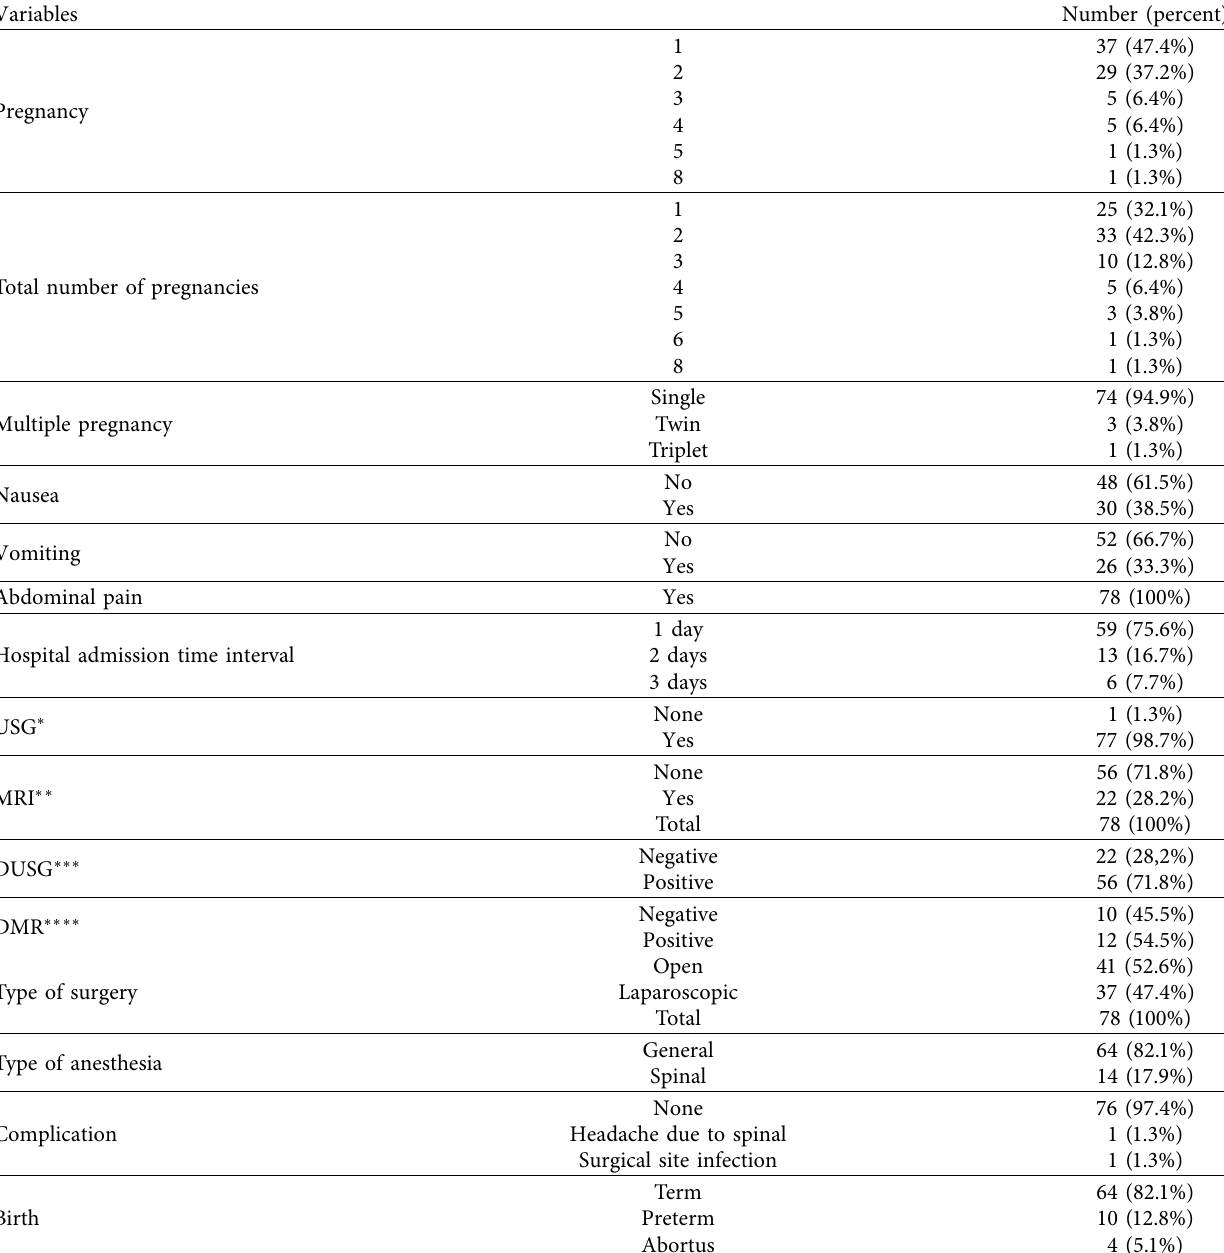
Table 1: Descriptive statistics of categorical variables.